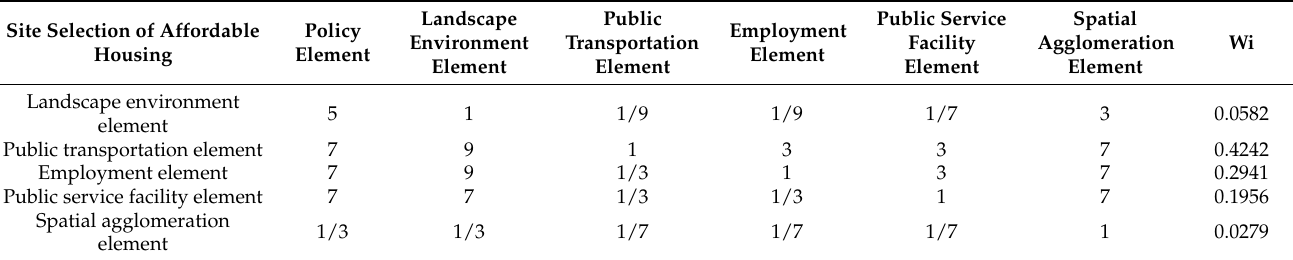
Table 7. Judgement matrix of